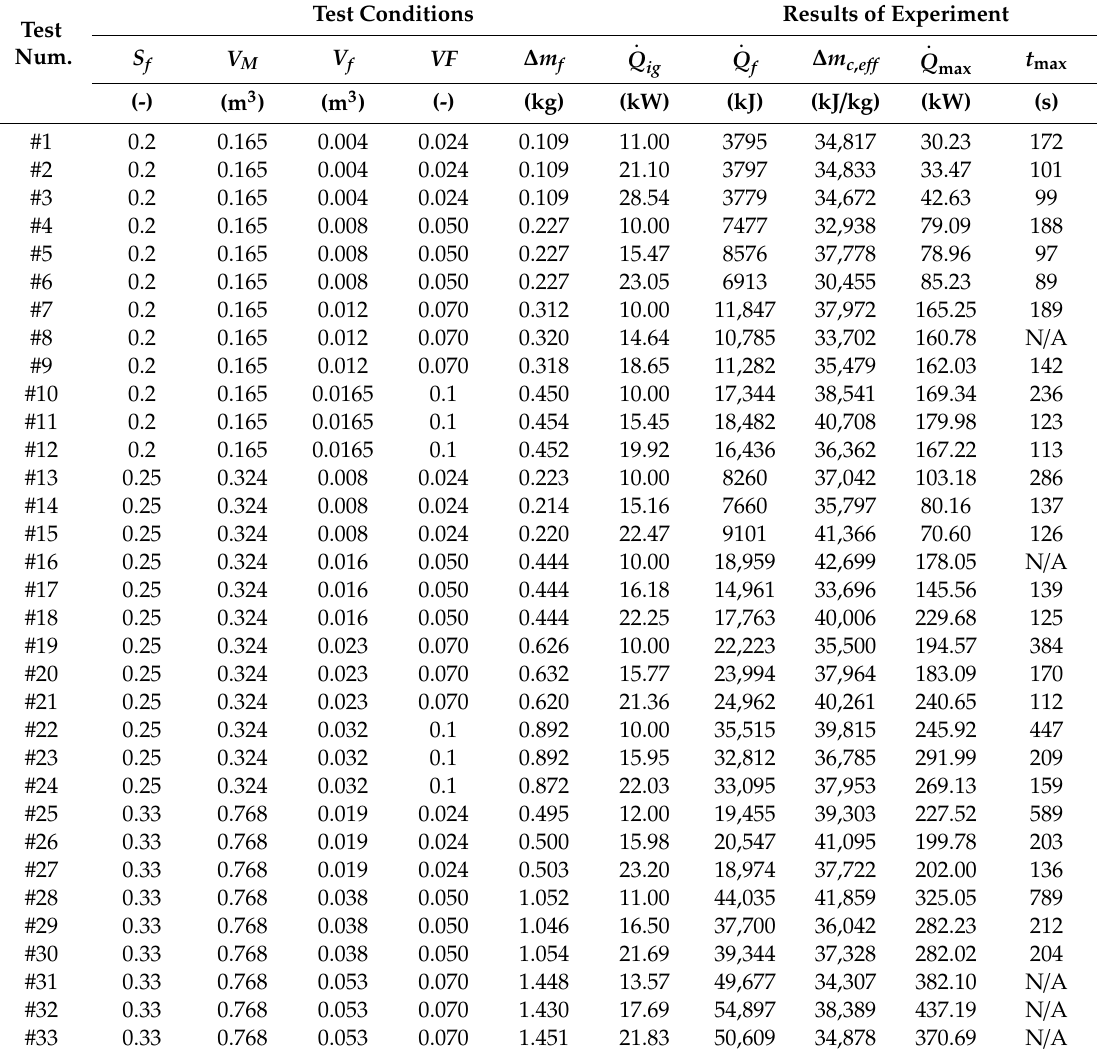
Table 4. Test conditions and summarized results of